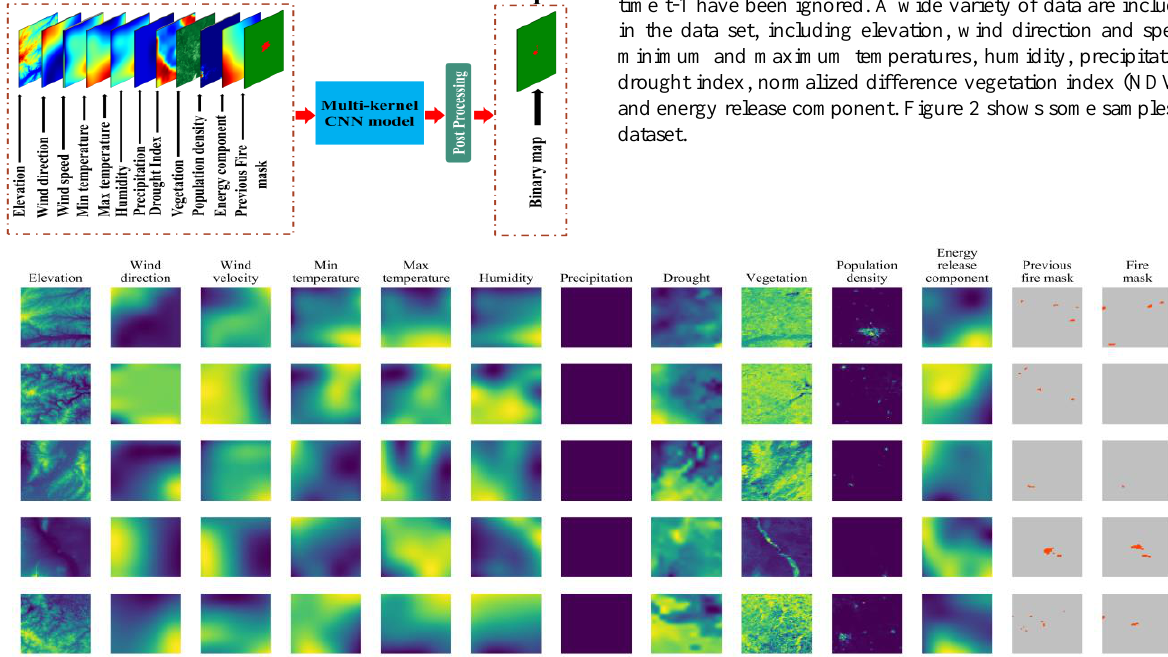
Figure 2 . Examples from dataset. Each row corresponds to a fire event and the columns represent the different environmental variables. The label image on the last column indicates fire at time t which is going to be